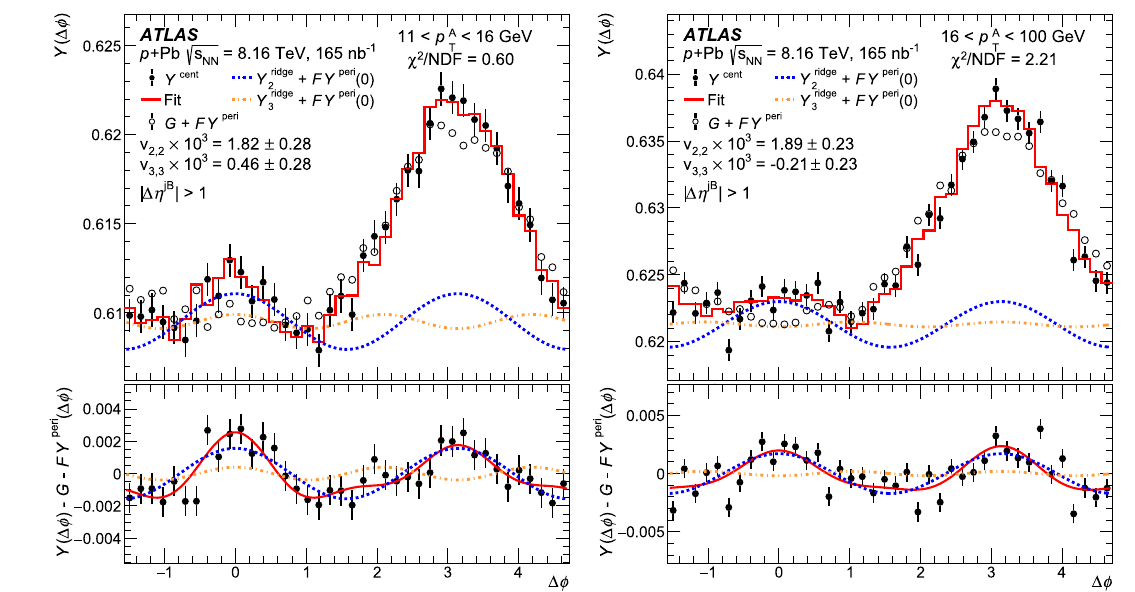
Fig. 2 Template fitting output for events with jet p T > 100 GeV order harmonic component, Y ridge , and the orange dotted line shows the 2 with 60–90% peripheral selection and 0–5% central selection. The third-order harmonic component, Y ridge (the n = 2 and n = 3 contri- 3 < 16 GeV and the right plot with left plot is made with 11 < p A butions to the sum in Eq. 1, respectively). The lower panels show the T < 100 GeV. In the upper panels, the open circles show the 16 < p A difference between the central data and the peripheral template along T scaled and shifted peripheral template with uncertainties omitted, the with the second and third harmonic functions. The resulting v 2 , 2 , v 3 , 3 , closed circles show the central data, and the red line shows the fit (tem- and global fit χ 2 /NDF values are reported in the legends. In these fits, plate and harmonic functions). The blue dashed line shows the second- NDF =